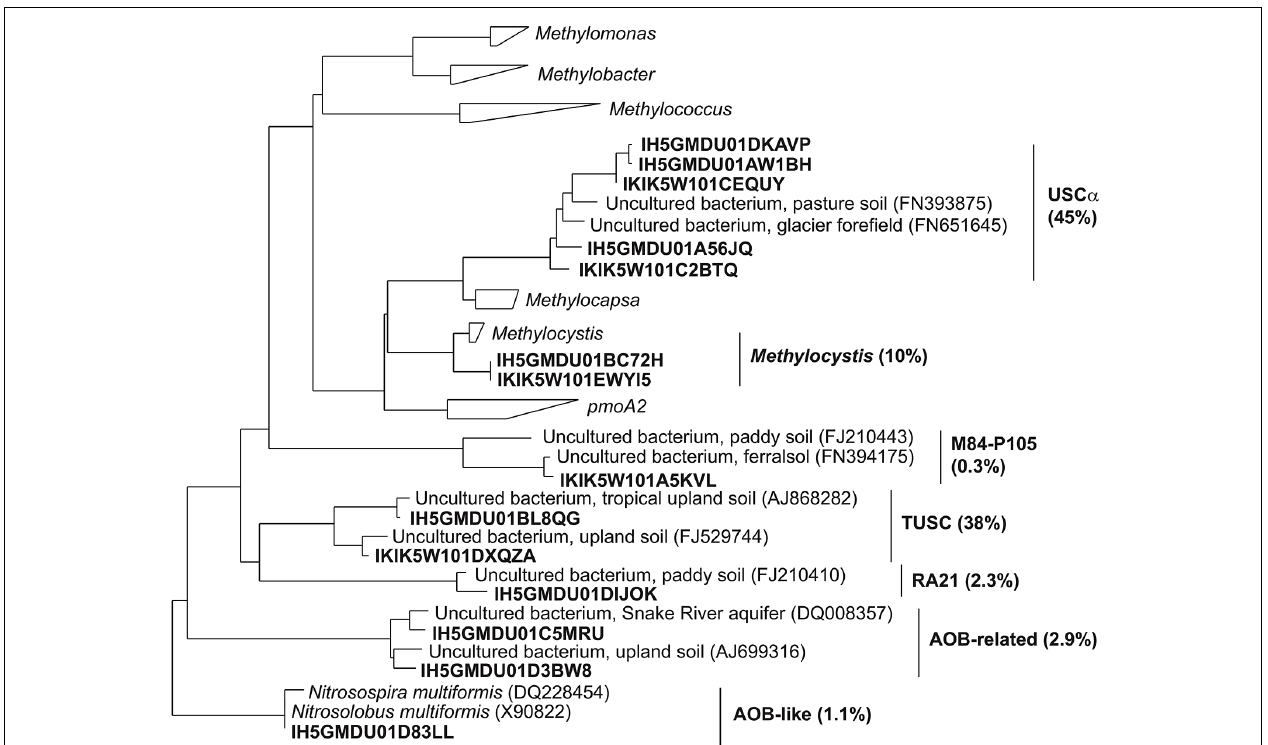
FIGURE 2 | Phylogenetic tree of representative pmoA pyrosequences (bold type) obtained in this study. The percentages of sequences corresponding to each clade are shown in parentheses.